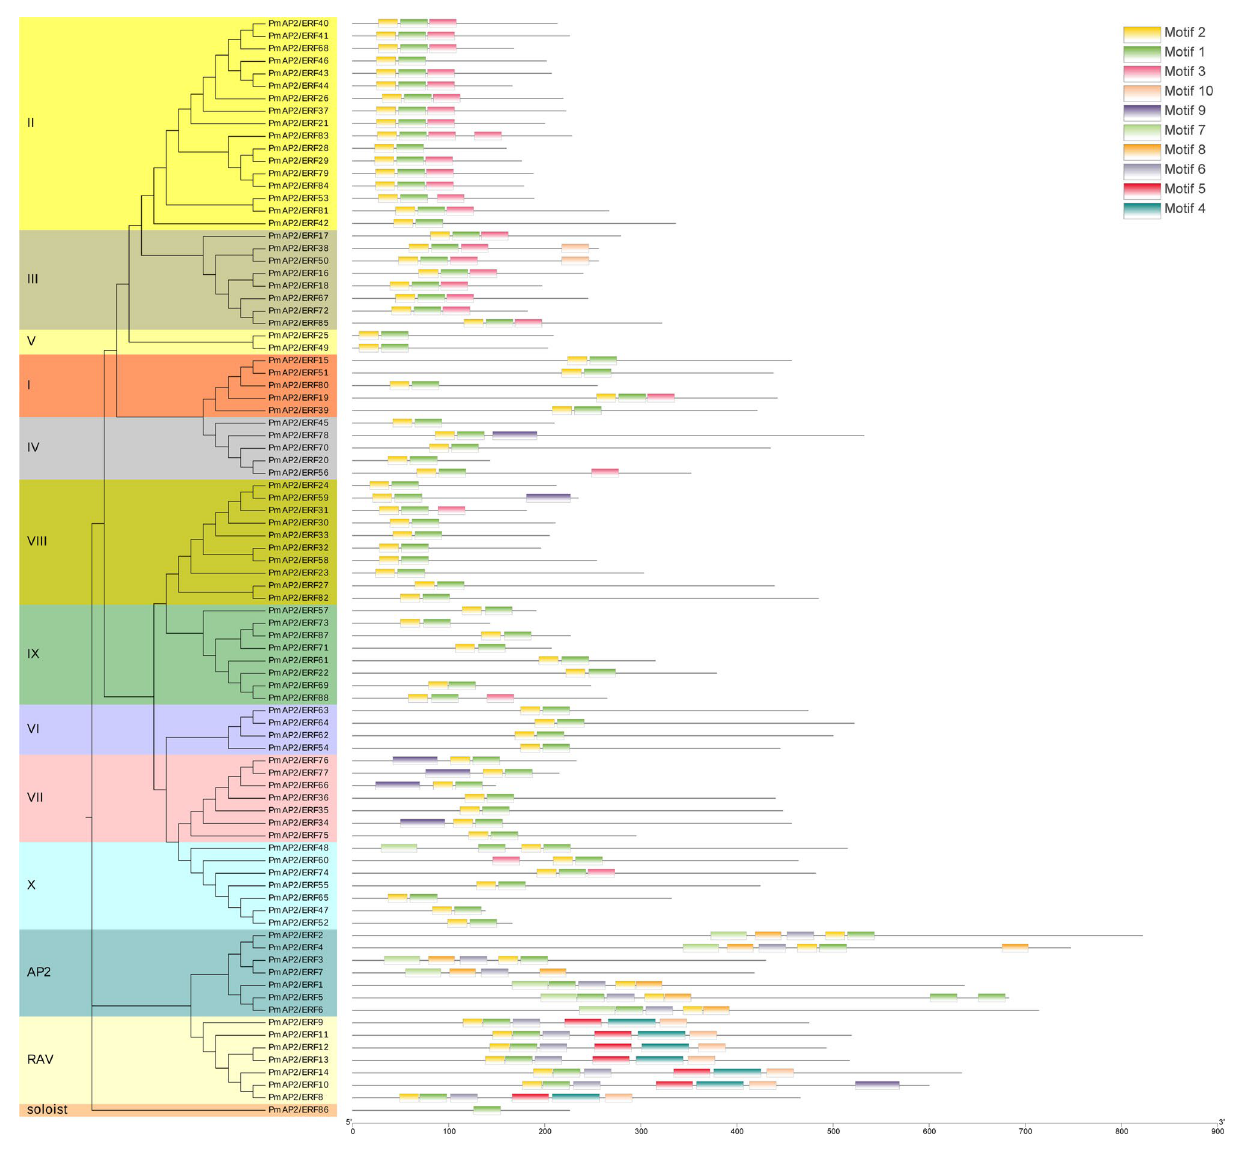
Figure 3. Phylogenetic grouping and motif distribution of AP2/ERF proteins in P. massoniana. Ten conserved motifs identified by MEME are indicated by different coloured boxes, and their relative positions are displayed. Details of each motif were shown in supplementary Figure